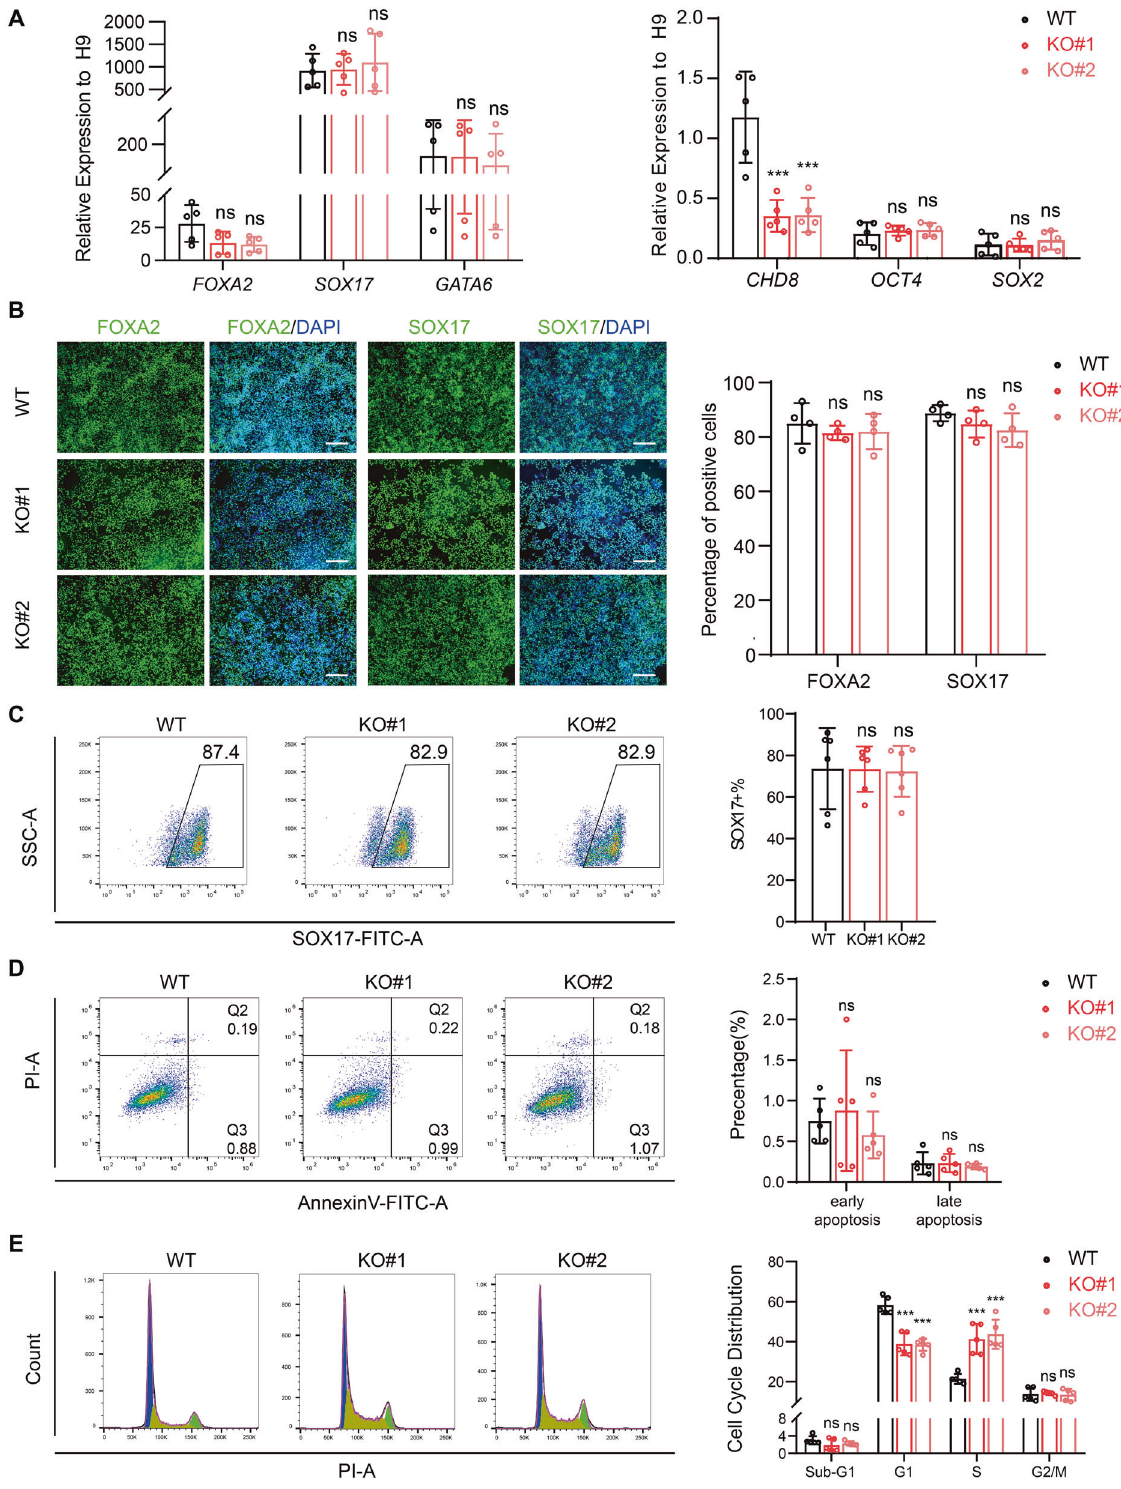
Fig. 4 CHD8 knockout does not affect de fi nitive endoderm differentiation. A Left, RT-qPCR analysis of endoderm genes FOXA2, SOX17 and GATA6 ; Right, RT-qPCR analysis of CHD8 and pluripotent genes OCT4 and SOX2 at day 3 of differentiation ( n = 5). Wildtype ESCs at day 0 served as control. B Immuno fl uorescence of endoderm marker FOXA2 and SOX17 in WT and CHD8KO groups at day 3 of differentiation. The percentage of FOXA2- or SOX17-positive cells was calculated ( n = 4). Scale bar = 200 µm. C Flow cytometric analysis showing the percentage of SOX17-positive cells in differentiated WT and CHD8-KO cells (n = 5). D , E AnnexinV/PI assay ( D ) and Cell cycle analysis using PI staining ( E ) in differentiated WT and CHD8-KO de fi nitive endoderm cells ( n = 5). The populations of different cell cycle phases were calculated in FlowJo (v10.4.0). The error bars represented the mean ± SD and the signi fi cance level was calculated by Student ’ s t -test (two-tailed, equal variance) (ns means not statistically signi fi cant, * P < 0.05, ** P < 0.01, *** P < 0.001).